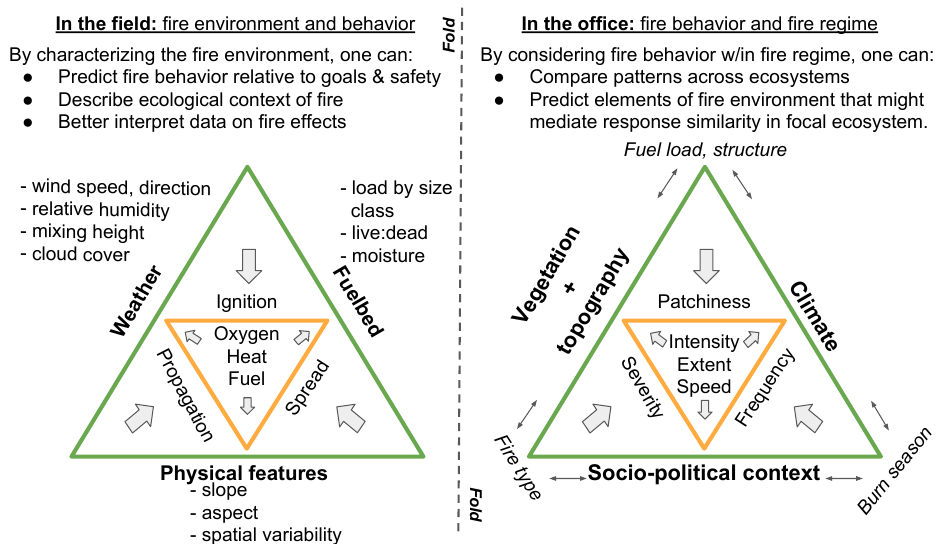
Figure 1. A wallet card describes the components of the fire environment most relevant to two arenas of the wildland fire professional: In the field, and in the office [1]. Terms related to the socio-ecological context of the fire regime follow McGranahan and Wonkka